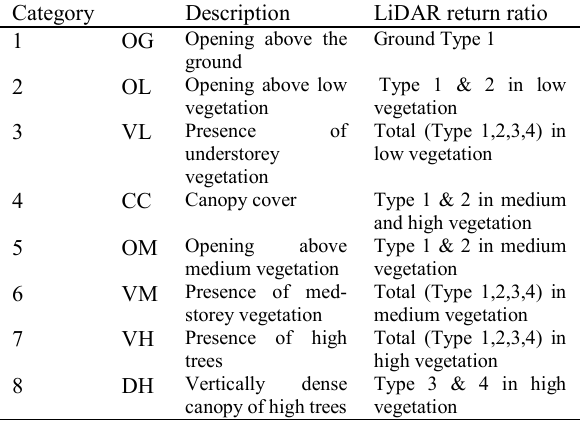
Table 2. Forest Characterization Scheme (after Miura and Jones,